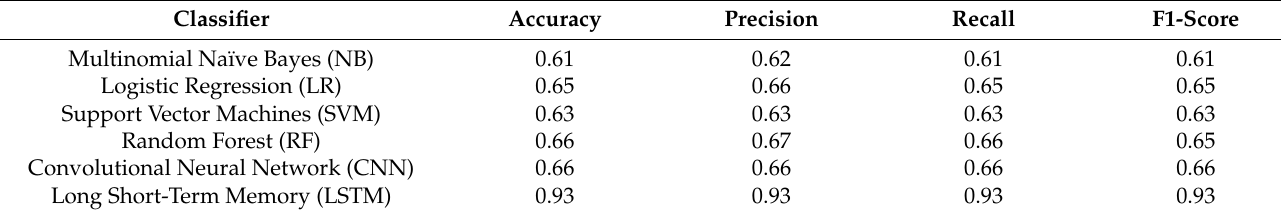
Table 5. Automatic classification results.